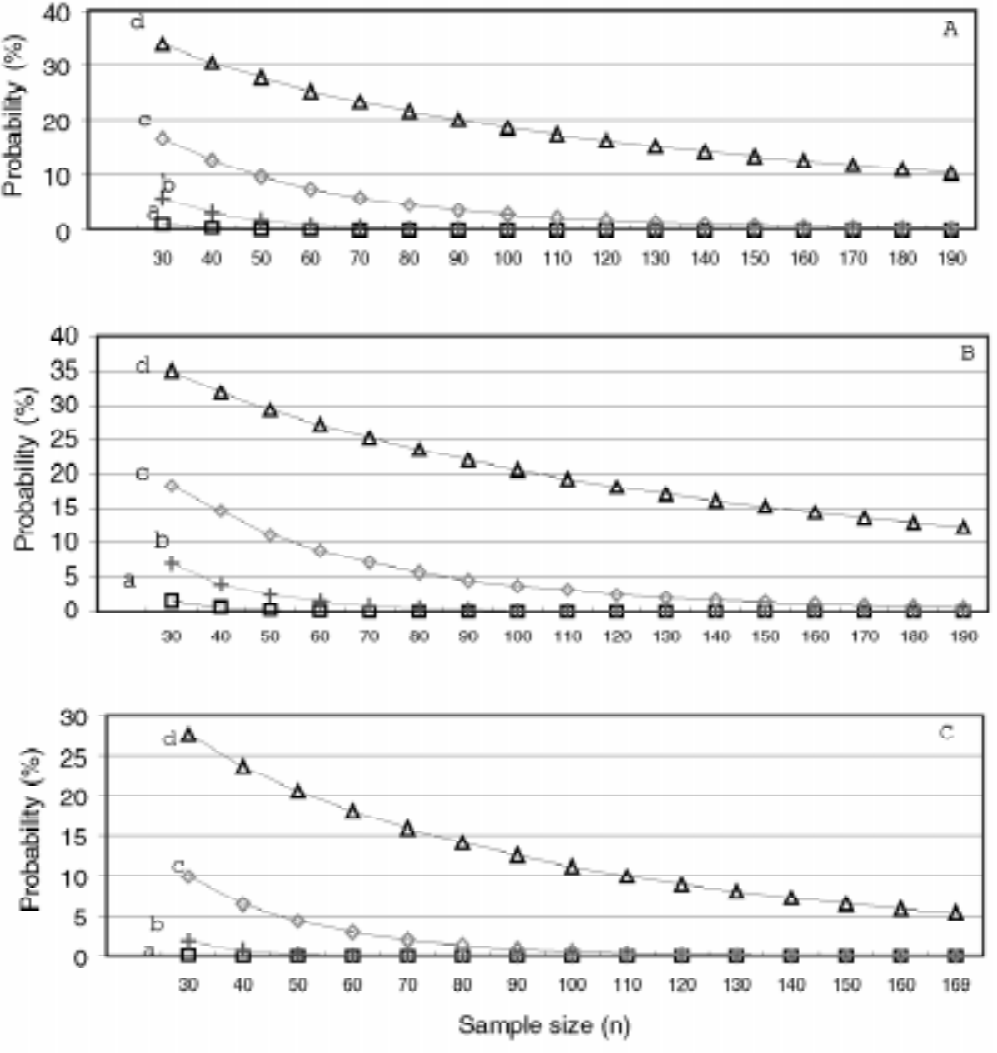
Figure 2 - Probability of populational heritability of grain productivity (h 2 ) a = 0.0 h 2 , b = 0.25 h 2 , c = 0.50 h 2 and d = 0.75 h 2 . Families from the (A) Carioca x Flor de Mayo crossing, during the dry season of 1997 (Lavras, MG), (B) Carioca x Flor de Mayo crossing, during the dry season of 1997 (Patos de Minas, MG) and (C) A-285 x Esal-645